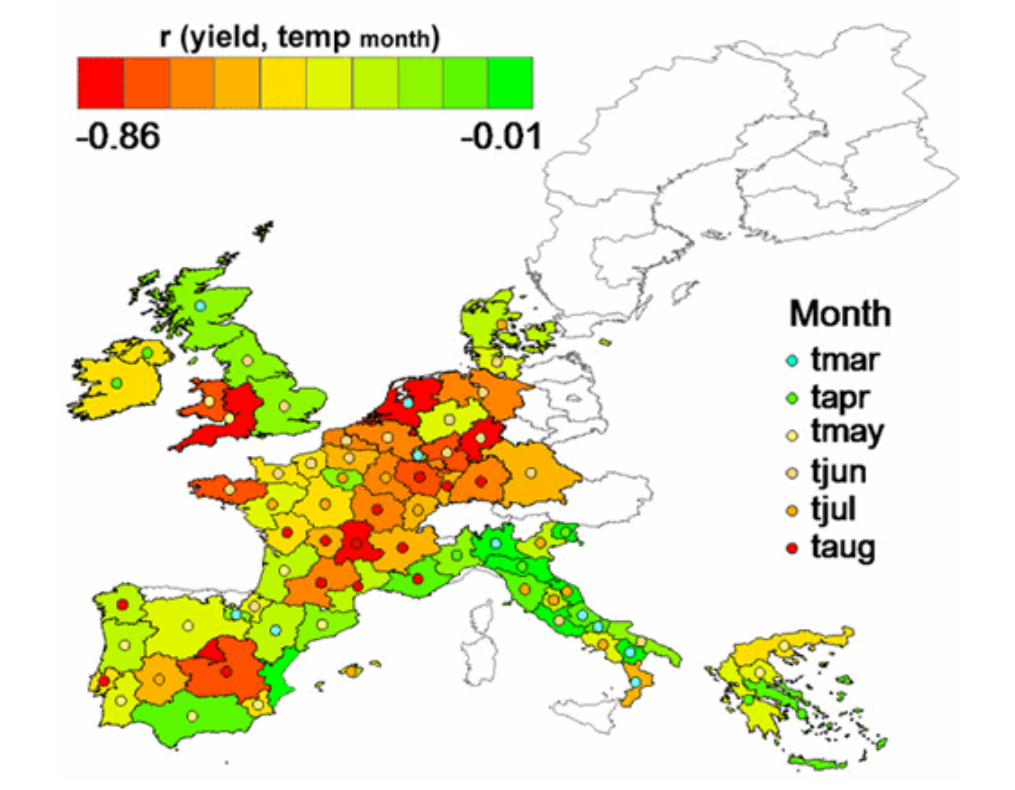
Fig. 5. Spatial distribution of the correlation between inter-annual variability in wheat yield anomalies and temp (the monthly temperature variable with the largest negative effect) [r(yield,temp month and relationships to average temperature (temp, °C) from